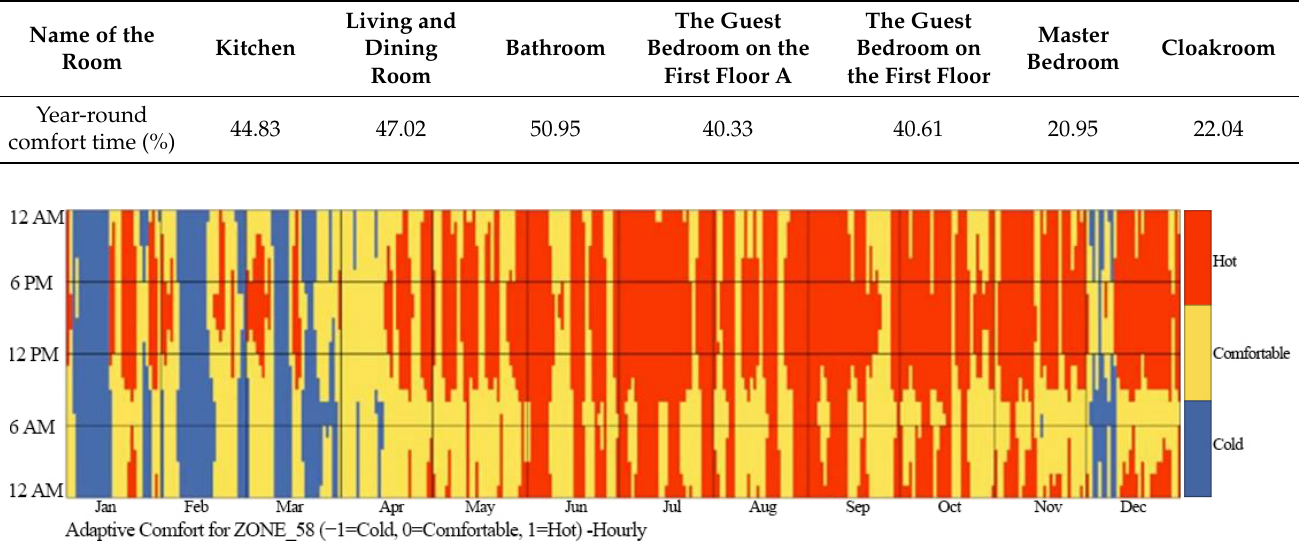
Figure 2. Natural ventilation state of the first-floor bedrooms in the year-round thermal comfort state diagram.